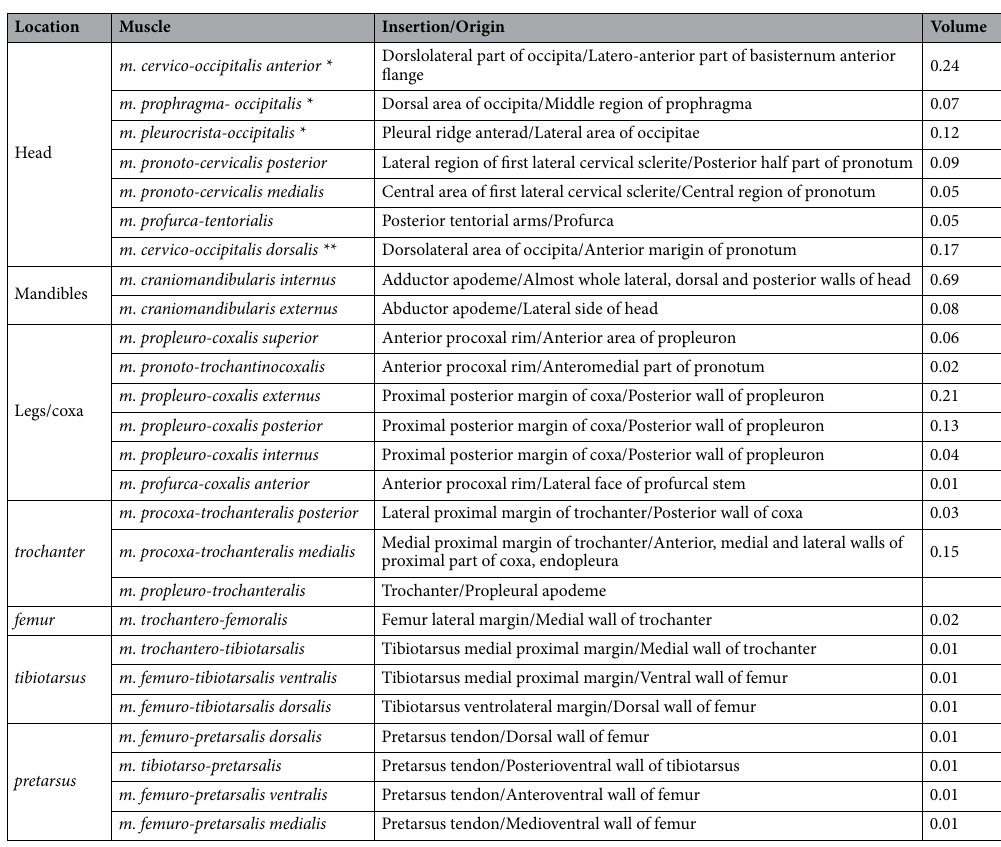
Table 1. The musculature of the digging apparatus of the sandworm beetle ( Gonopus tibialis ) larva. *Muscles uplifting the head. **Muscles responsible for lateral